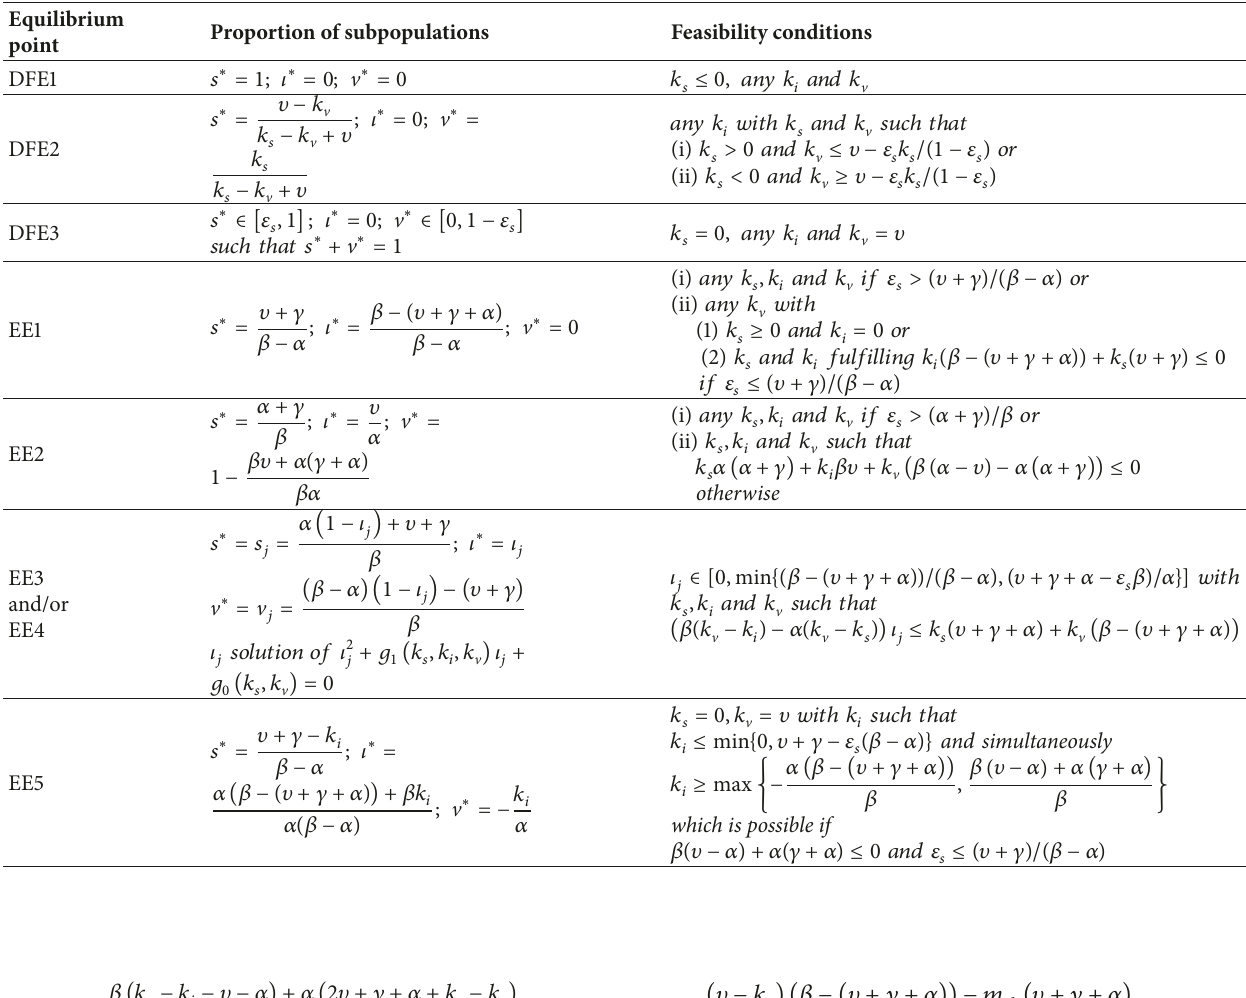
Table 1: Equilibrium points and their feasibility